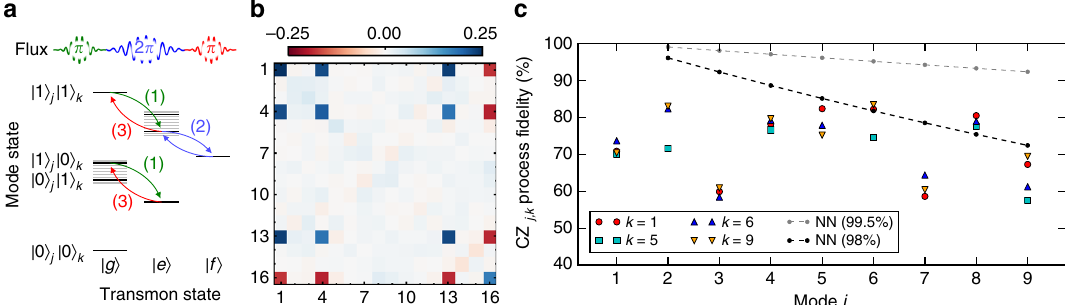
Fig. 4 Controlled-phase gate between two arbitrary modes. a Protocol for controlled-phase (CZ) gate between an arbitrary pair of modes, with j indicating the control mode and k indicating the target mode of the gate: (1) The state of mode j is swapped to the transmon via a transmon-mode iSWAP pulse at the frequency difference between the transmon g j i (cid:2) e j i transition and mode k . (2) A CZ gate is performed between mode k and the transmon, by applying two frequency-selective iSWAPs from energy level e 1 j i to level f 0 j i and back, mapping the state e 1 j i to (cid:2) e 1 j i . (3) The state of the transmon is swapped back to mode j , reversing the iSWAP in (1). b Process matrix for the CZ gate between modes j = 6 and k = 8, corresponding to a process fi delity of 82% (see Supplementary Note 17 for details on state preparation and measurement). c Fidelities from process tomography for 38 pairs of memory modes with k = 2, 5, 6, 8. The process fi delities are extracted from sequences that include SPAM errors, and are conservative estimates of the gate fi delities. For comparison, the dashed black and gray lines show the decay in fi delity for a two-qubit gate between qubit 1 and qubit j in a corresponding linear array comprising only nearest-neighbor gates with fi delities of 99.5 35 and 98%,